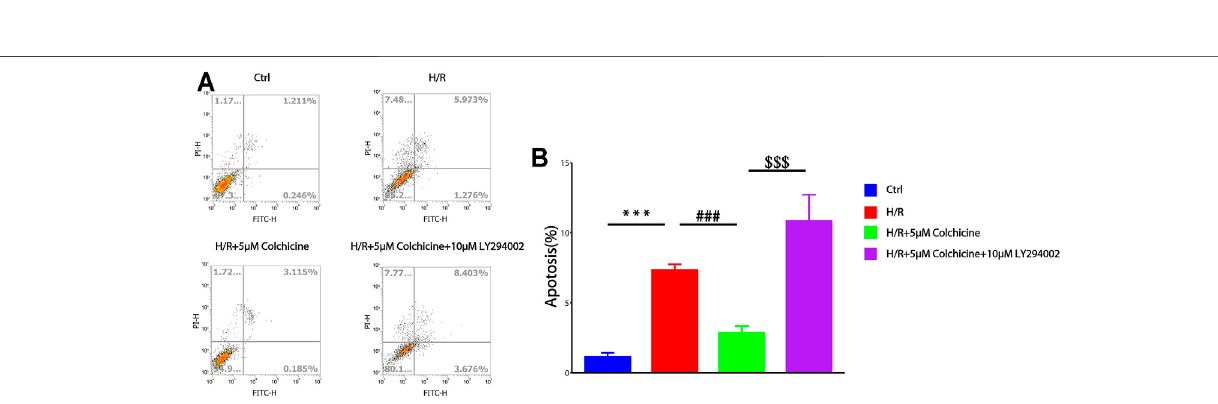
Frontiers in Pharmacology |